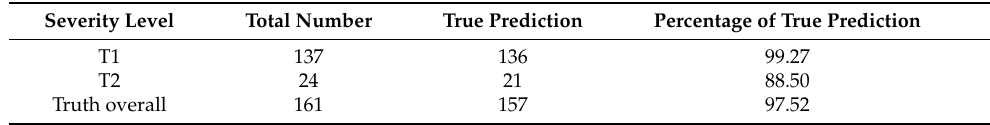
Table 5. The producer accuracy for ANN training model for T1 and T2 severity level. The overall accuracy is 97.52%, and Kappa is 0.90.